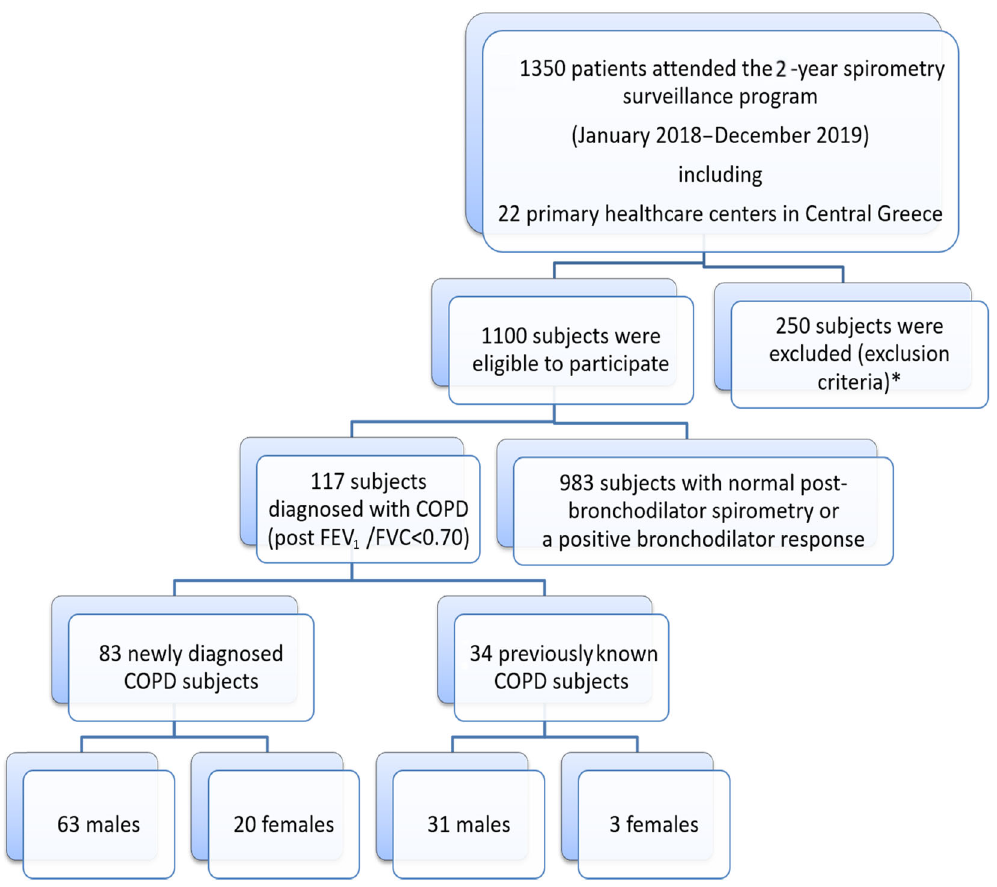
Fig. 1 Flowchart of the study selection process. In our study, 1350 patients attended the 2-year spirometry surveillance program, from January 2018 to December 2019, in 22 Primary Health Centers in Central Greece. From all these patients, 1100 were smokers and ex-smokers aged 40 – 65 years old, the others 250 subjects were excluded according to the exclusion criteria of our study. From those subjects were eligible to participate, 117 subjects diagnosed with COPD (post FEV1/FVC<0.70) and 983 subjects had either normal postbronchodilator spirometry or positive bronchodilator response. Of the 117 patients diagnosed with COPD, 83 were diagnosed for the fi rst time and 34 were previously known COPD patients. According to the gender, those with newly diagnosed COPD patients, 63 were males and 20 females, while of those with previously known COPD, 31 were males and only 3 were females. *Exclusion criteria: no smoking history, a history of lower or upper respiratory infection or antibiotic treatment within the last month, an operative procedure or acute myocardial infarction within the last three months, or inability to perform